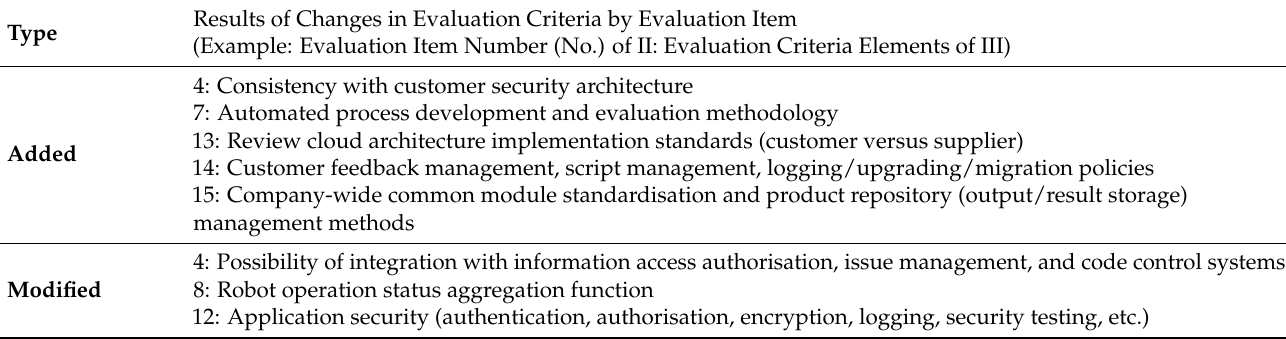
Table 9. Updated selection criteria following the second Delphi evaluation